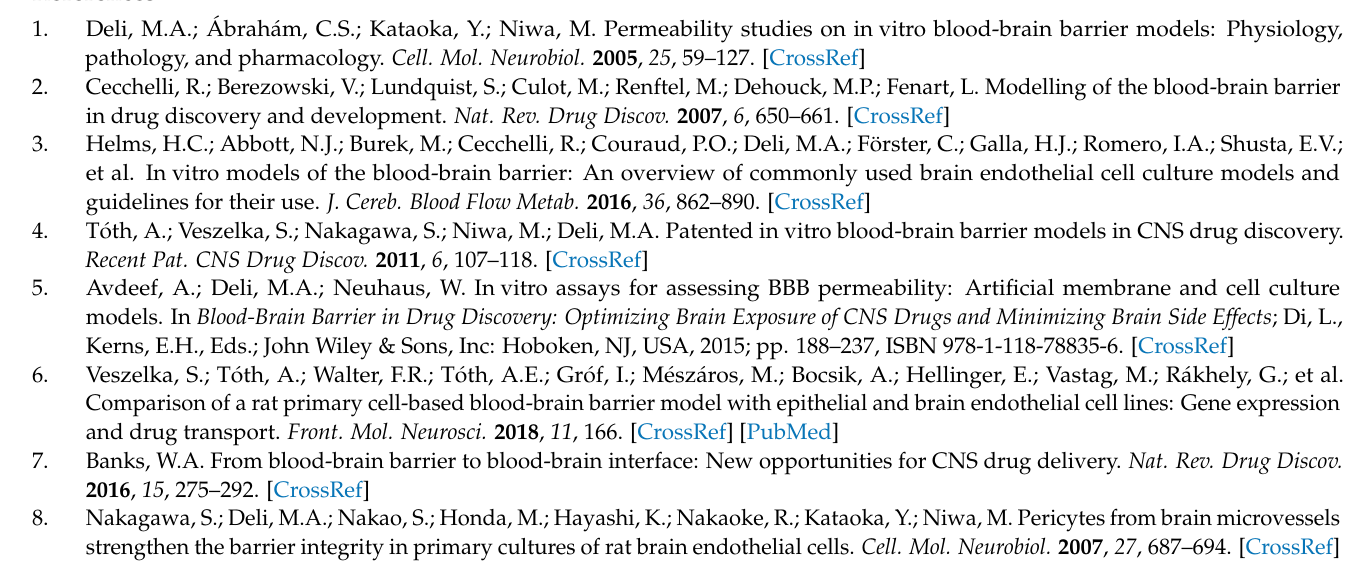
blot, Figure S1: Expression of ABCC transporters in different BBB models. Figure S2. Expression of ABCC transporter genes in different BBB models determined by quantitative PCR. (a)